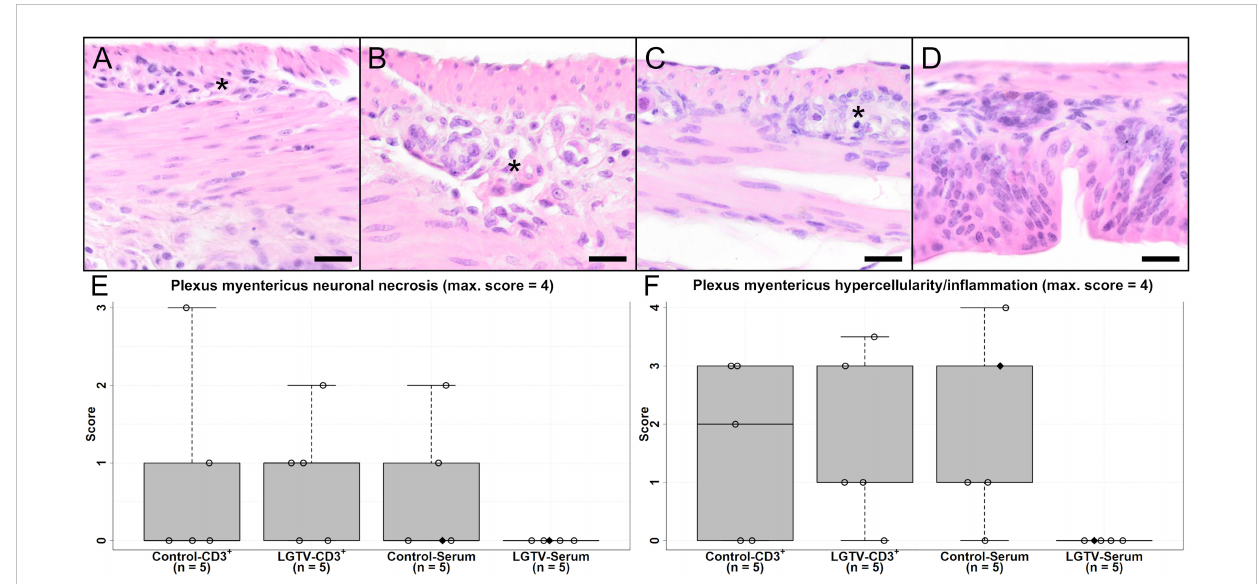
FIGURE 8 H&E stained sections of caecum of one representative mouse from each group (A) CD3 + T cell transfer from control donors; (B) CD3 + T cell transfer from LGTV infected donors; (C) serum transfer from control donors; (D) serum transfer from LGTV infected donors). The plexus myentericus displays varying degrees of ganglioneuritis in (A – C) (asterisk). No histopathological changes in the plexus myentericus of the mouse from the serum transfer of LGTV infected donor group (D) are detectable. Scale bars: 20 µm. (E, F) display box plots of the scoring values for plexus myentericus neuronal necrosis (E) and plexus myentericus hypercellularity/in fl ammation (F) of caecum for each group. Mice that differed in their clinical state from other mice in the control and LGTV serum recipient group are highlighted as rhombus shaped symbols in the box